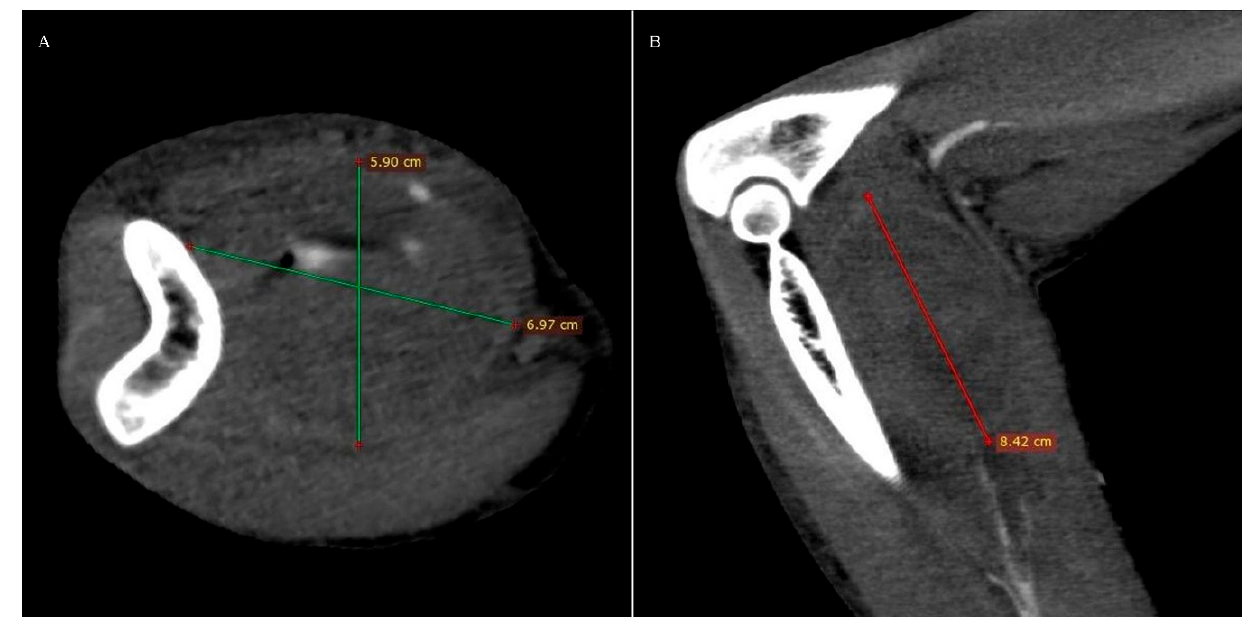
Figure 2. Right upper limb computed tomography angiography. MIP reconstruction. Leakage of the contrast agent beyond the lumen was found, consistent with active bleeding from the injured bra- chial artery.